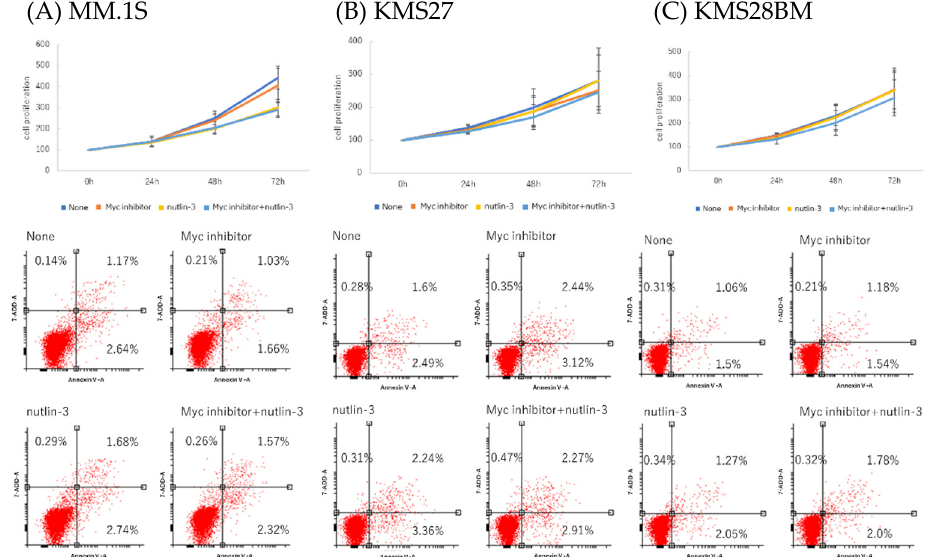
Figure 9. The myeloma cell line proliferation and apoptosis after treatment with Myc inhibitor 10058-F4 and nutlin-3. ( A ) MM.1S, ( B ) KMS27, and ( C ) KMS28BM were treated with 20 µM of Myc inhibitor. MM.1S was treated for 48 h with 1 µM nutlin-3, while the other two cell lines were treated for 72 h with 10 µM nutlin-3. Experiments of proliferation were performed in triplicate. Error bars show the standard deviation (SD) within triplicated experiments. Blue, no treatment; orange, with 20 µM of Myc inhibitor; yellow, with 1 or 10 µM of nutlin-3; light blue, with co-treatment of Myc inhibitor and nutlin-3. Apoptosis was measured once after treatment for 48 h or 72 h. In dot plot, left top, no treatment; right top, with 20 µM of Myc inhibitor; left bottom, with 1 or 10 µM of nutlin-3; right bottom, with co-treatment of Myc inhibitor and nutlin-3.